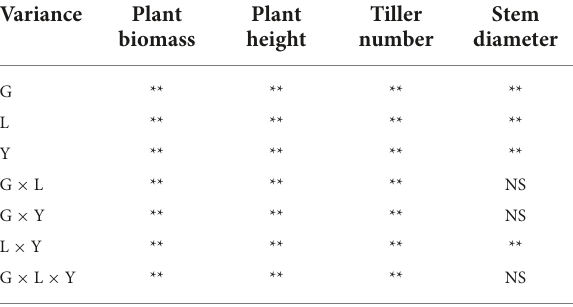
TABLE 2 Significance of effect of genotype (G), location (L), year (Y), genotype × location (G × L), genotype × year (G × Y), location × year (L × Y), genotype × location × year (G × L × Y) on plant biomass, plant height, tiller number and stem diameter (model I).